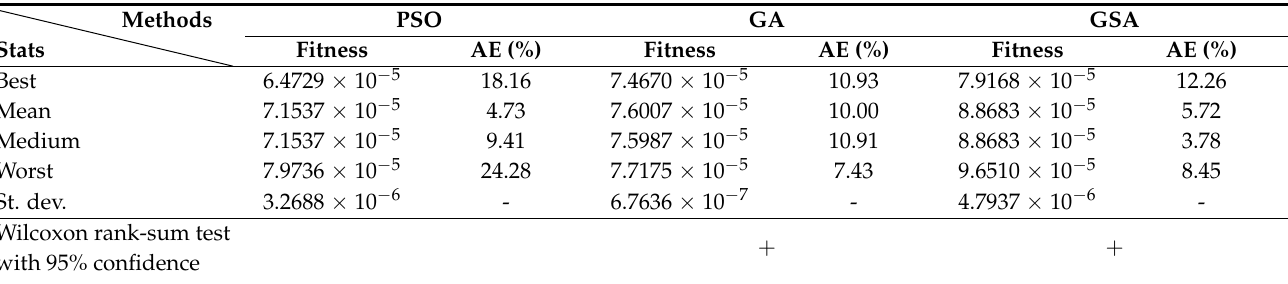
Table 1. Statistical values of the SPTECPs using the optimization methods for the single-phase transformer, 4 kVA, 250–125 V at 50 Hz.